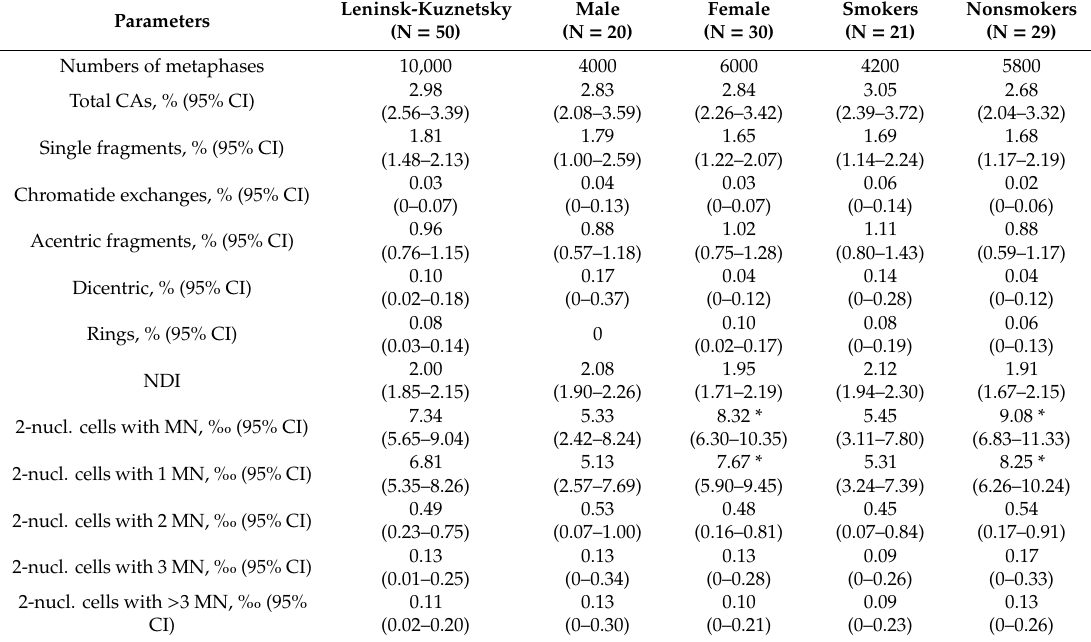
Table 4. Chromosomal aberrations (CAs) and micronuclei in cytochalasin-blocked (CBMN) frequency in the examined